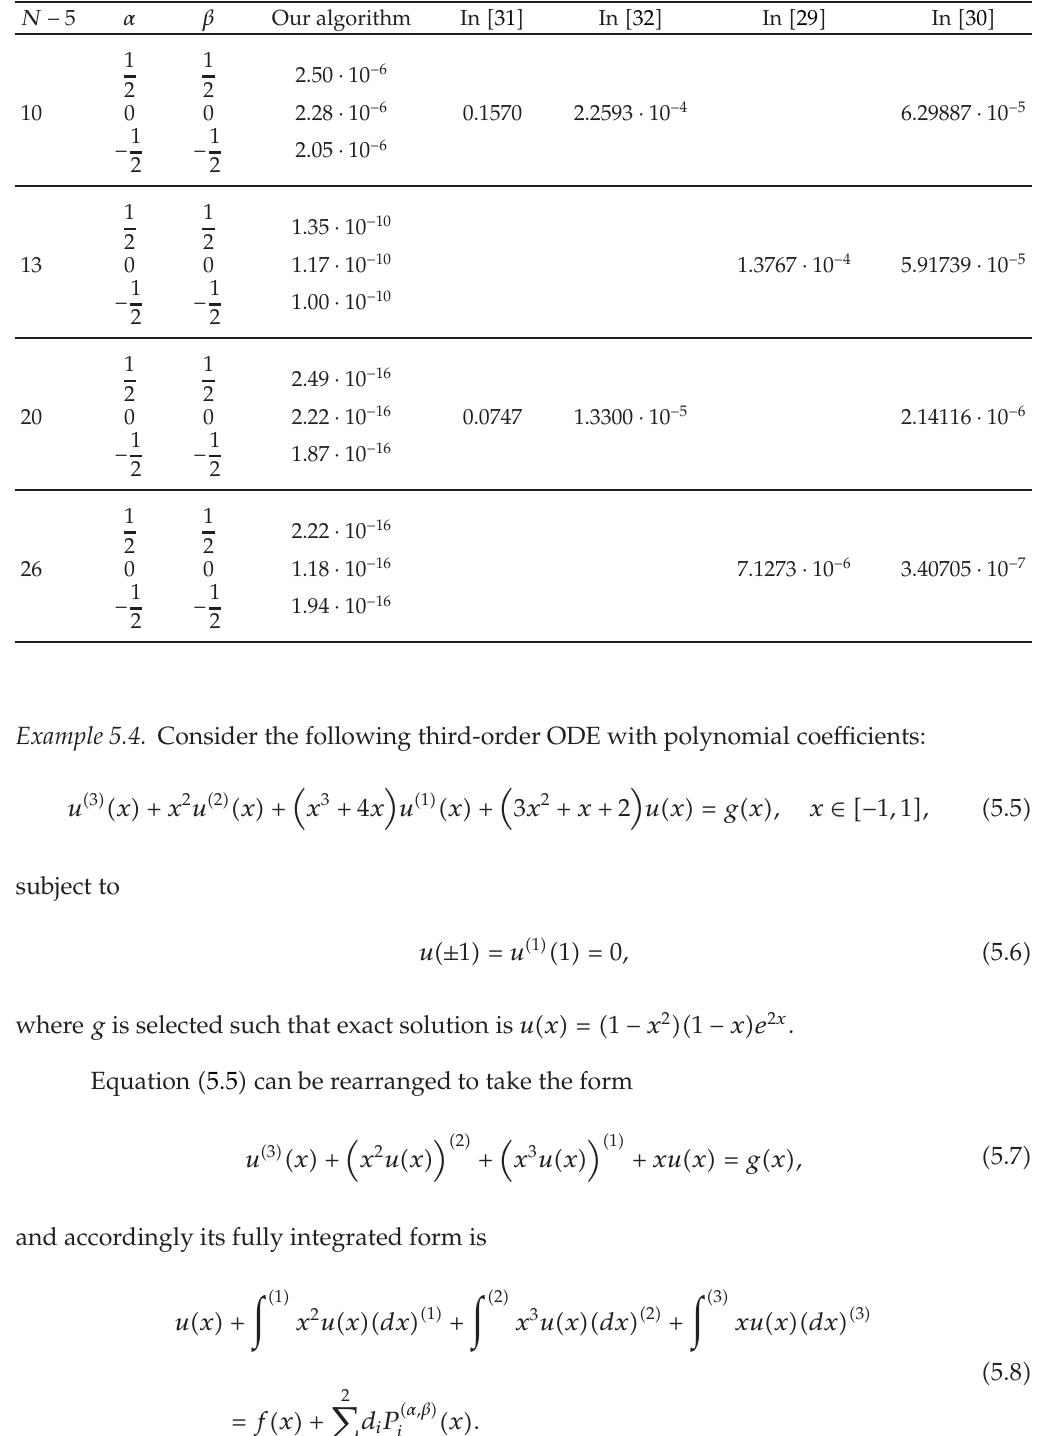
(cid:6) 15 , 18 , 25 , 31, for Example 5.3. N for N